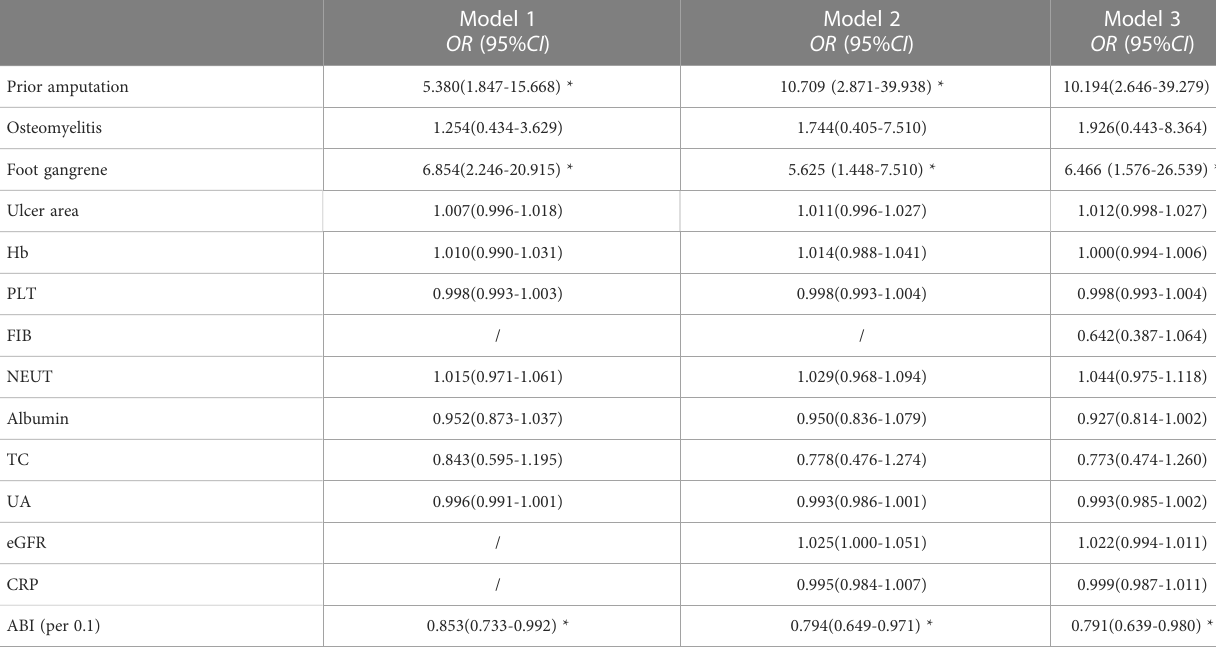
TABLE 4 The ordinal logistic regression analysis of major and minor amputation risks in patients with diabetic foot